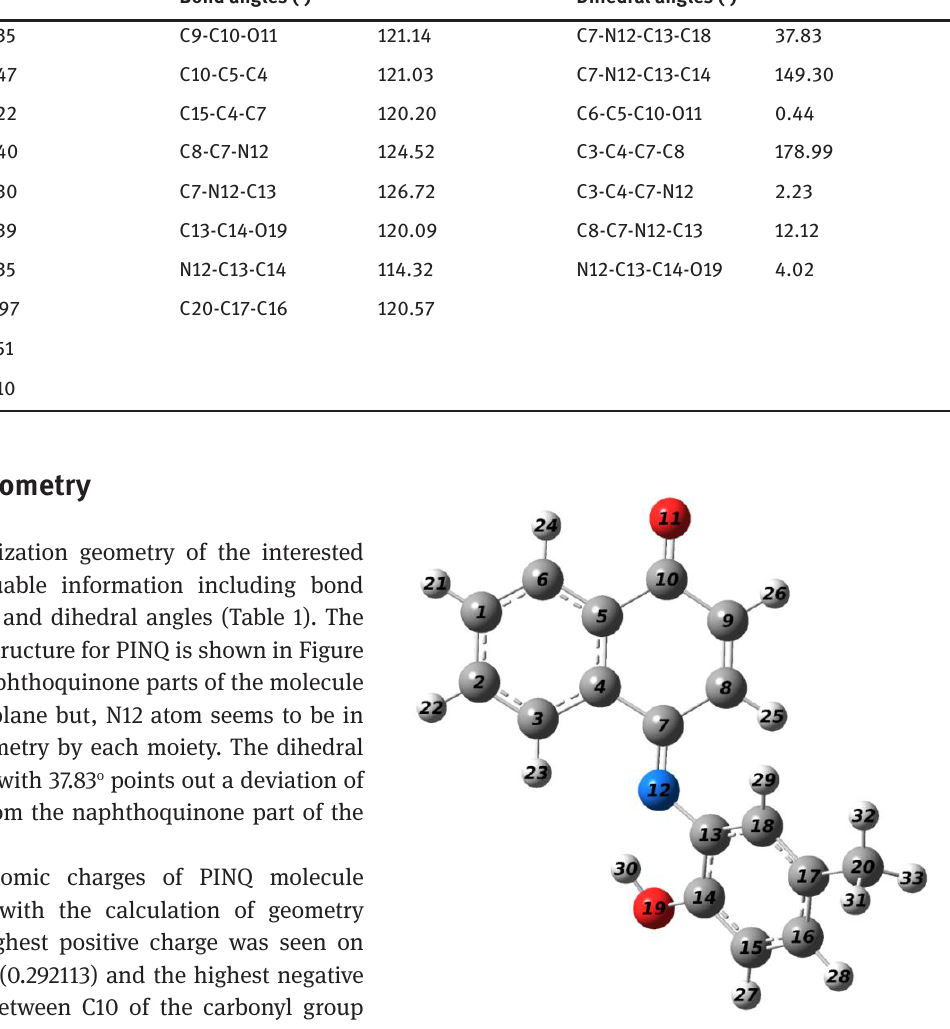
Table 1: Representative bond lengths, bond and dihedral angles of PINQ molecule.